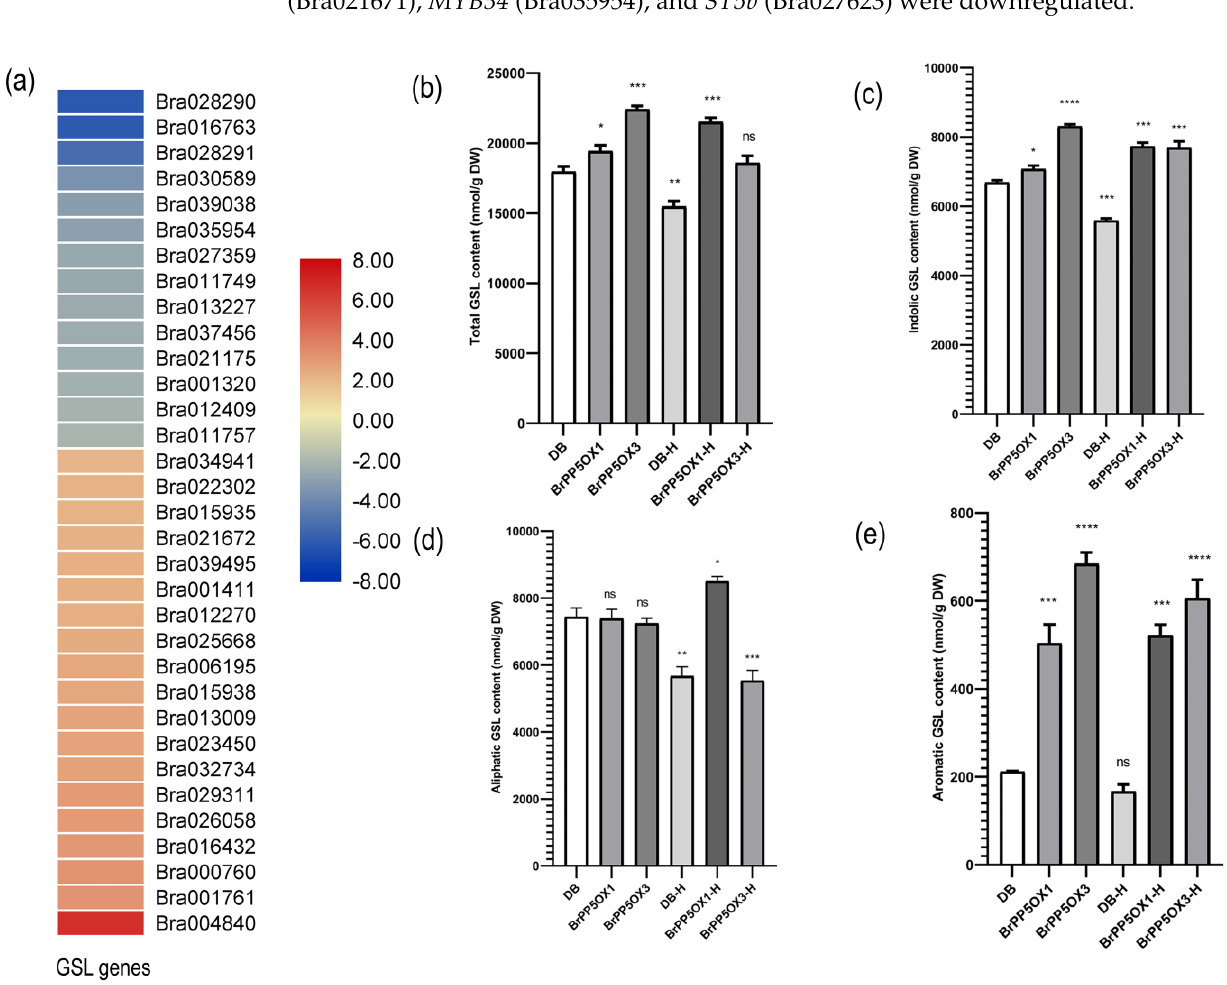
Figure 6. Expression pattern of GSL biosynthesis-related genes and GSL concentration in transgenic and control lines under normal and heat stress conditions. ( a ) The heatmap depicts the expression pattern of GSL genes in BrPP5 overexpressing transgenic lines compared to non-transgenic controls. ( b – e ) The graphs represent the UHPLC results (described in the methods section), revealing glucosinolate types and their concentration (nmol/g DW) in aerial tissues of 2-month-old transgenic and control lines ( n = 15 or more) grown under optimal and high temperature/heat (37 °C for 1 h) stress conditions. ( b ) Total GSL content in non-transgenic controls (DB), transgenic lines (BrPP5OX1, BrPP5OX3), heat-stressed non-transgenic controls (DB-H), and heat-stressed transgenic lines (BrPP5OX1-H, BrPP5OX3-H). ( c ) Aliphatic GSL content in non-transgenic controls (DB), transgenic lines (BrPP5OX1, BrPP5OX3), heat-stressed non-transgenic controls (DB-H), and heat-stressed transgenic lines (BrPP5OX1-H, BrPP5OX3-H). ( d ) Indolic GSL content in non-transgenic controls (DB), transgenic lines (BrPP5OX1, BrPP5OX3), heat-stressed non-transgenic controls (DB-H), and heat-stressed transgenic lines (BrPP5OX1-H, BrPP5OX3-H). ( e ) The aromatic GSL content in non-transgenic controls (DB), transgenic lines (BrPP5OX1, BrPP5OX3), heat-stressed non-transgenic controls (DB-H), and heat-stressed transgenic lines (BrPP5OX1-H, BrPP5OX3-H). Each column represents the mean values derived from UHPLC duplicates, while error bars denote the standard deviations. One-way ANOVA (Dunnett’s multiple comparisons test) was performed using GraphPad Prism 8.0.2 to determine the significant variation from non-transgenic controls grown under optimal growth conditions. Ns = non-significant; * = p < 0.05; ** = p < 0.01; *** = p < 0.001; **** = p <